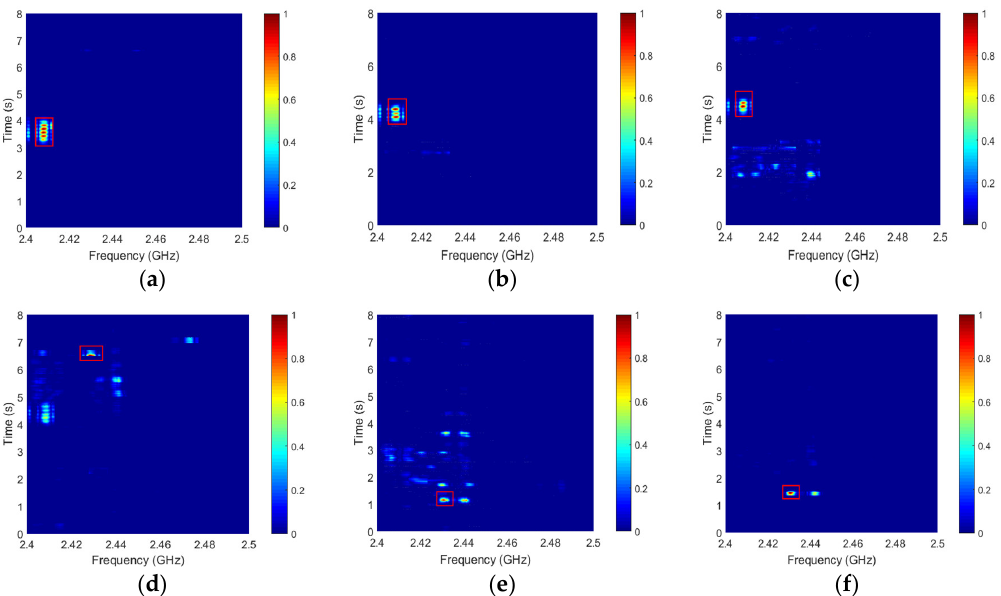
Figure 11. The results for the higher-order cumulant (HOC) method outdoors at distances of ( a ) 500 m, ( b ) 1000 m, ( c ) 1500 m, ( d ) 2000 m, ( e ) 2500 m, and ( f ) 3000 m.